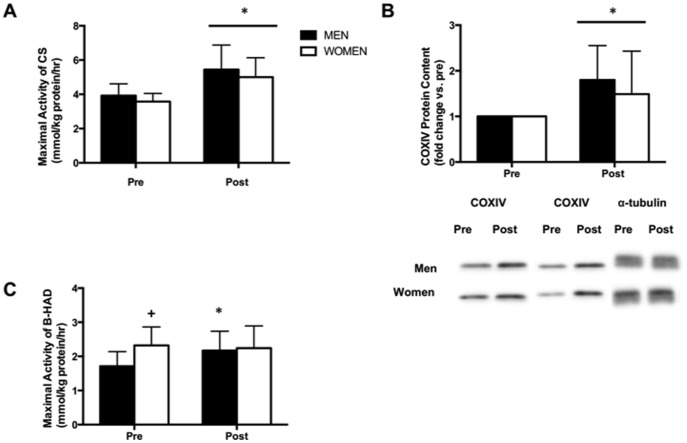
Very low-volume SIT improves skeletal muscle mitochondrial capacity.Measured in muscle biopsy samples obtained from the vastus lateralis before (PRE) and 72 h after (POST) 6-week SIT in men and women. Maximal activity of citrate synthase (A), protein content of COXIV (B) and maximal activity of β-HAD (C). Values are means ± SD (n = 7 per group). Representative Western blots for 2 men and 2 women are shown for COXIV. α-tubulin was used a loading control and representative Western blots are shown. *P<0.05, pre- vs. post-training; +p<0.05, men vs. women at same time point; line denotes a main effect.